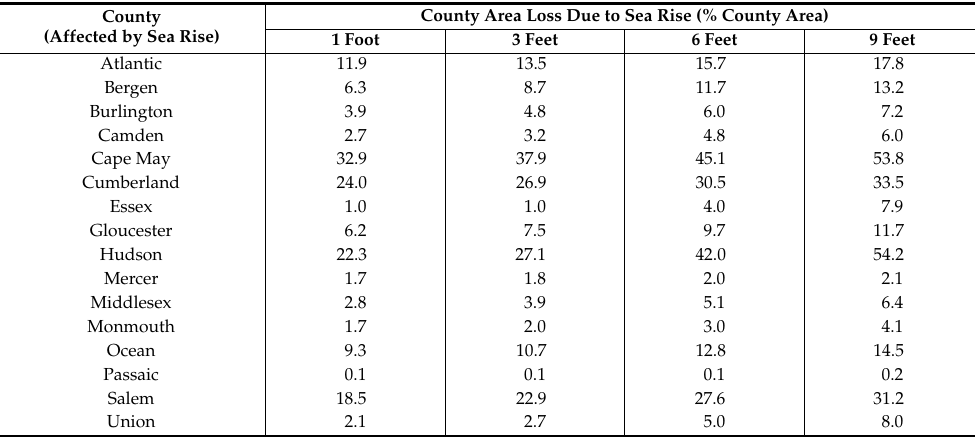
Table 12. County area loss (%) due to sea rise in the state of New Jersey (USA) (based on original ArcGIS Pro 2.6 [23] analysis of data from the National Oceanic and Atmospheric Administration (NOAA) [31]).